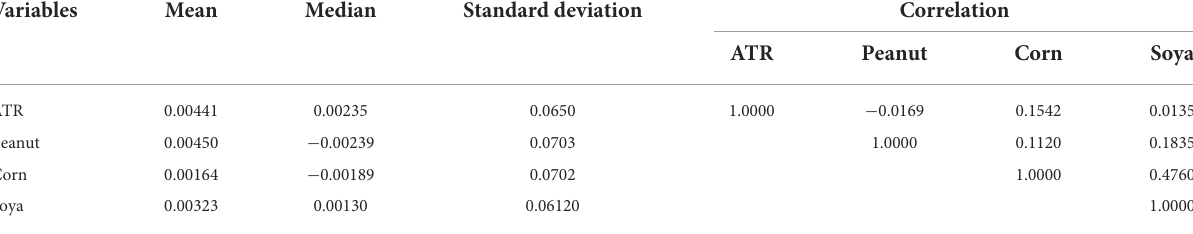
TABLE 1 Descriptive statistics for commodity price variations.